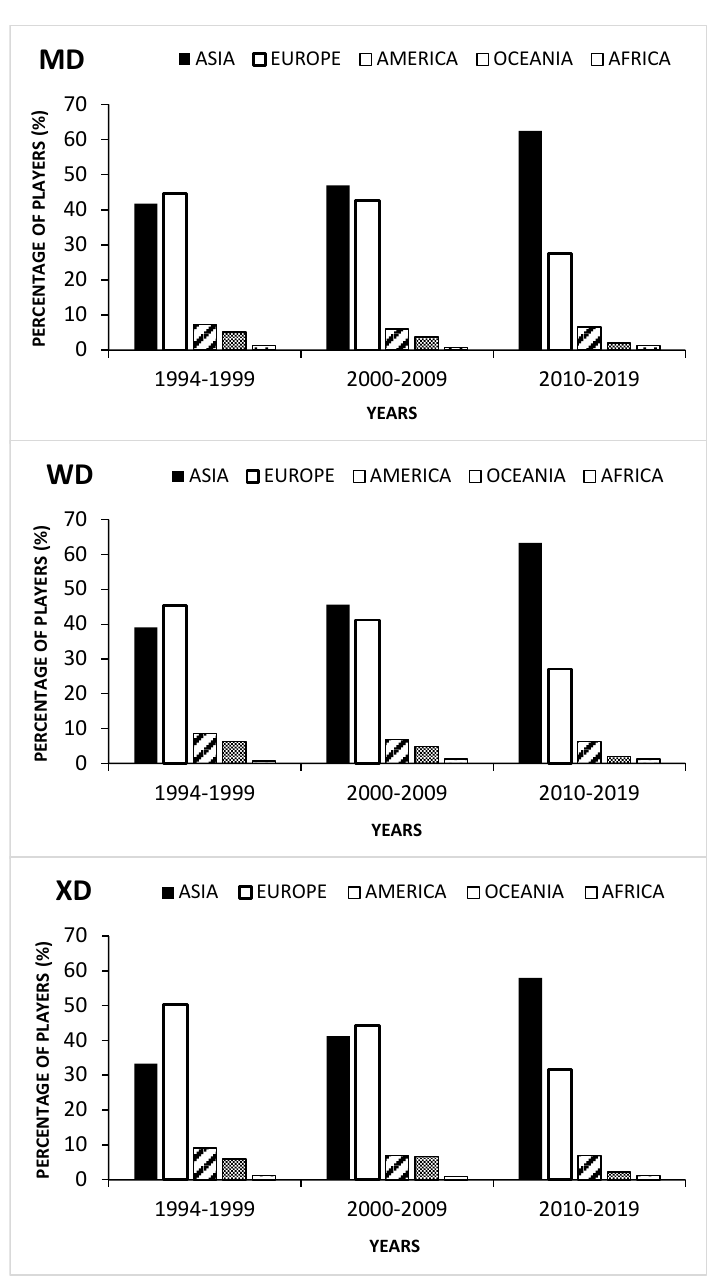
Figure 4. Percentage of top 100 World Ranking badminton players from each continent (men’s doubles (MD), women’s doubles (WD) and mixed doubles (XD)).